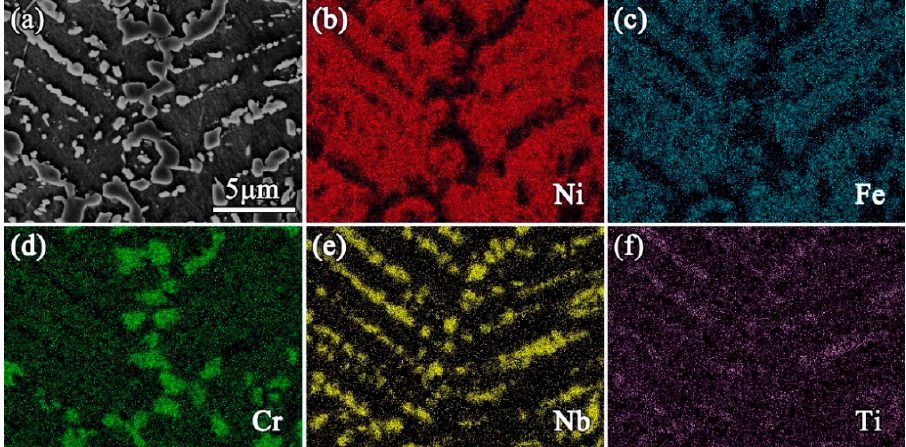
Figure 3. EDS elemental distribution of the as-fabricated sample: ( a ) SEM image of the tested field,